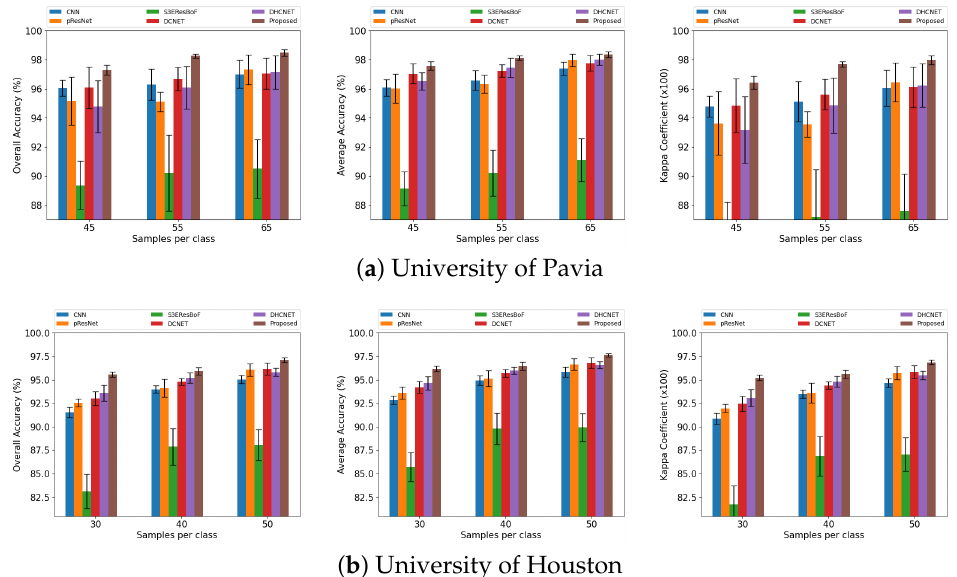
Figure 8. From left to right, graphical representation of the OA, AA, and Kappa Coefficient (coupled with their corresponding standard deviations) reached by each classification model.